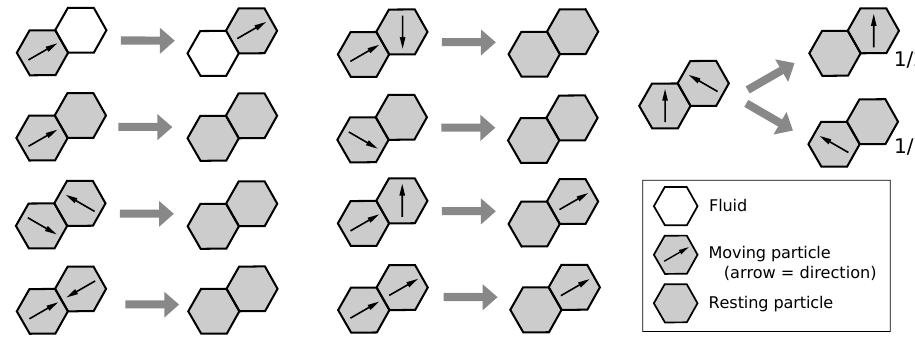
Figure 4. Rules for motion and frictional (inelastic) collisions, illustrated here for one of the six lattice directions.